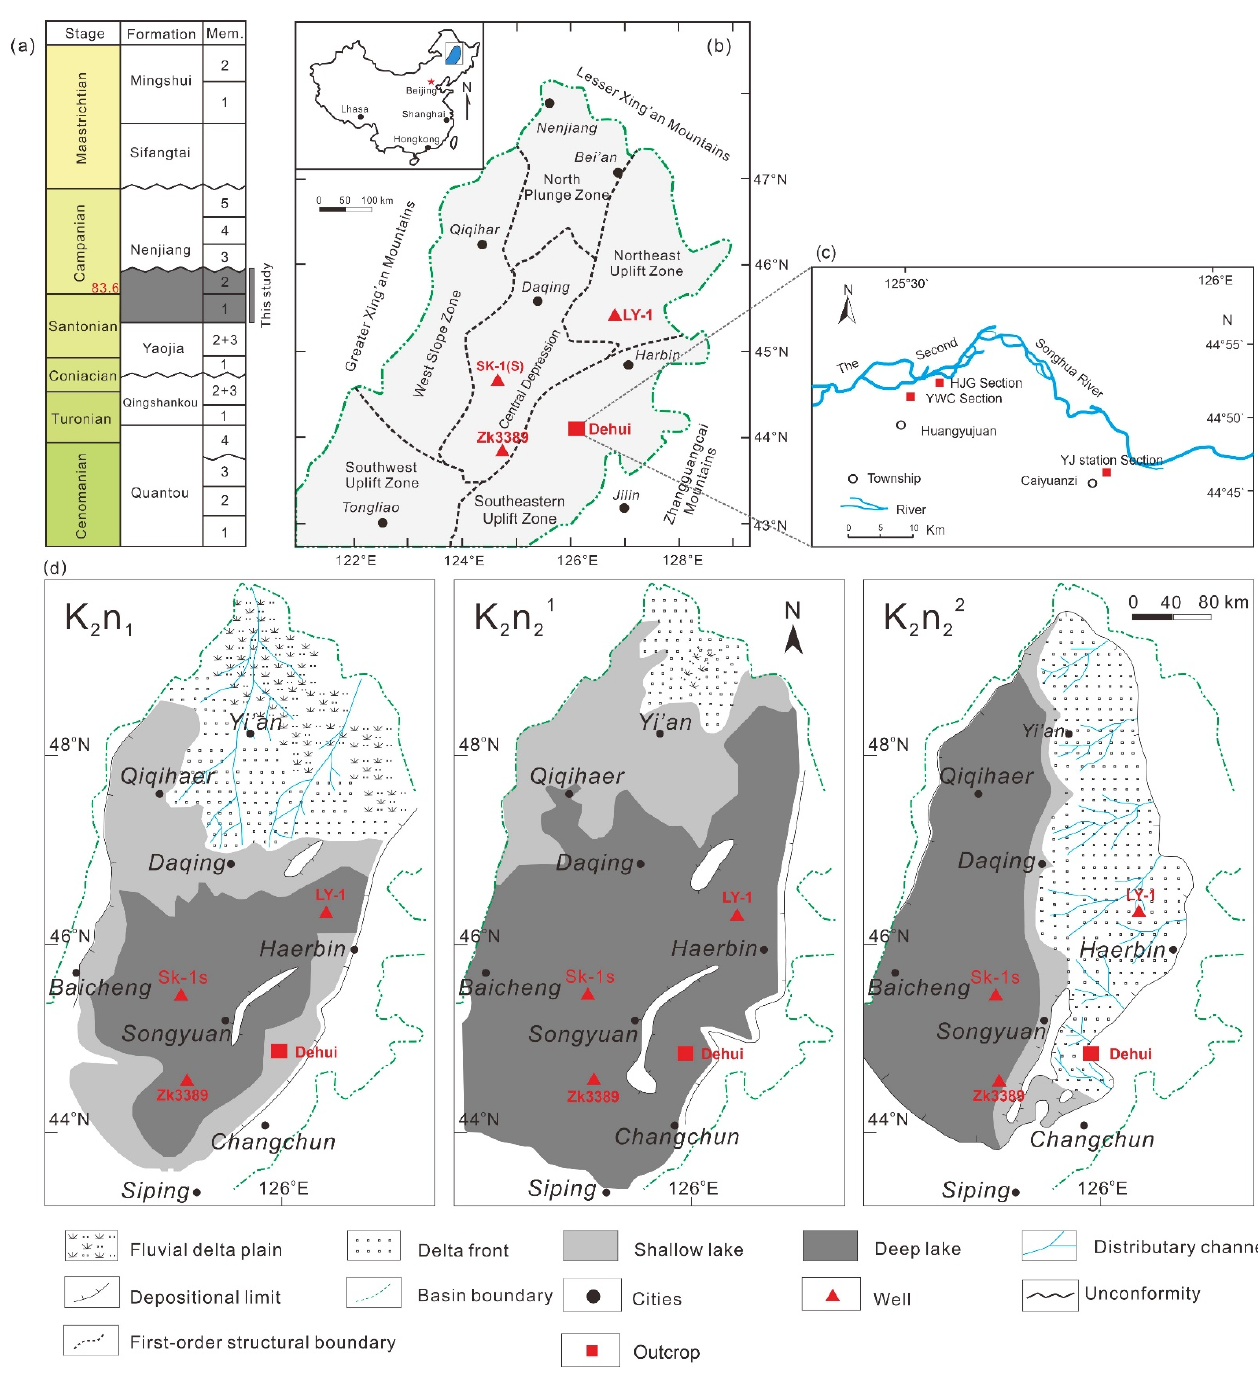
Figure 1. Geological setting of the Nenjiang Formation. ( a ) Geological time framework of SK-1s core, the dashed area represents the study interval (1 + 2 member of Nenjiang Formation). ( b ) Geographic distribution of the SK-1 core and compiled study sites, modified from [6]. ( c ) The composite section located in Dehui area, modified from [7]. ( d ) The evolution of the sedimentary facies of Nenjiang Formation from K 2 n 1 to K 2 n 2 , modified from [8].